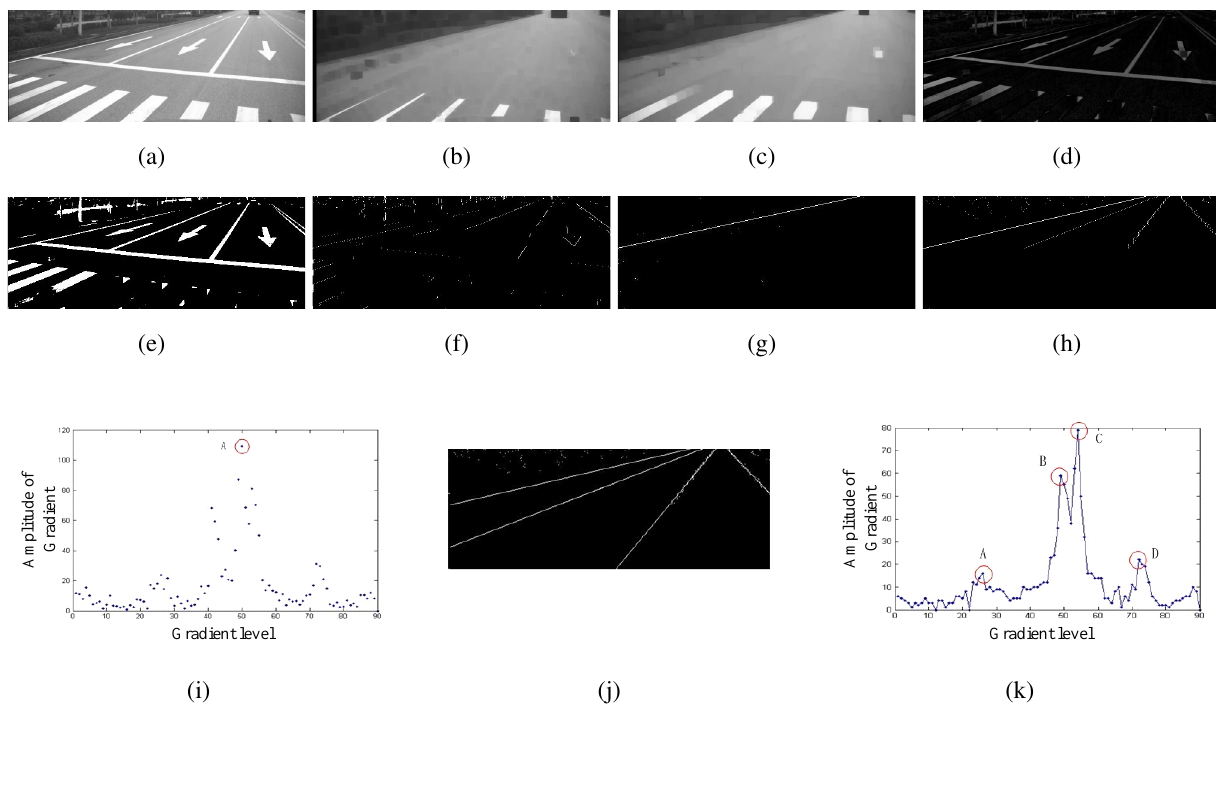
Figure 6. Step by step results by proposed lane detection. ( a ) Original Image. ( b ) Image after open operation. ( c ) Image after dilate operation. ( d ) Image after top-hat transform. ( e ) Threshold. ( f ) First scan. ( g ) RANSAC. ( h ) Second scan. ( i ) Gradient contribution function after first scan. ( j ) RANSAC. ( k ) Gradient contribution function after second